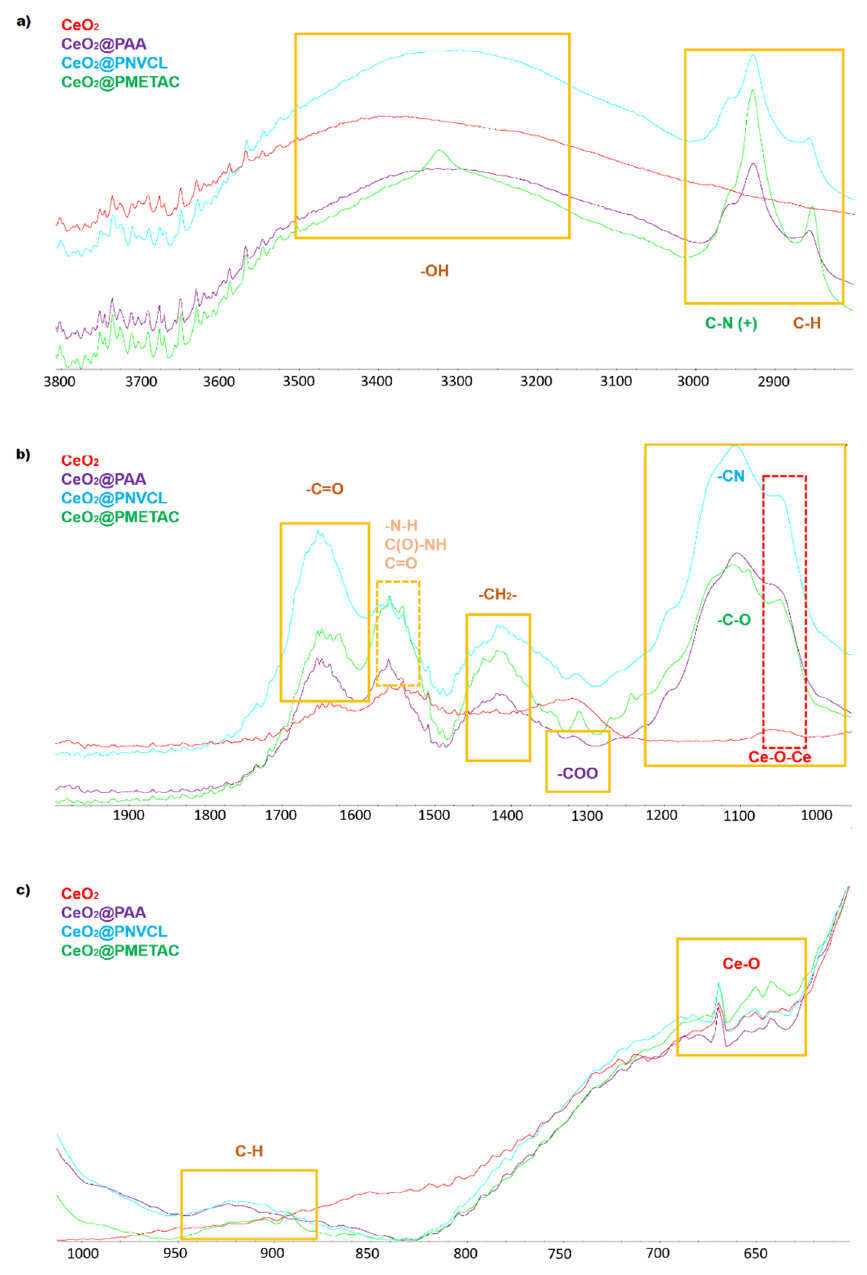
Figure 4. FTIR zooms of all samples in 3 different areas: ( a ) top, 3800–2800 cm − 1 ; ( b ) middle, 2000–1000 cm − 1 ; and ( c ) bottom, 1000–600 cm − 1 .